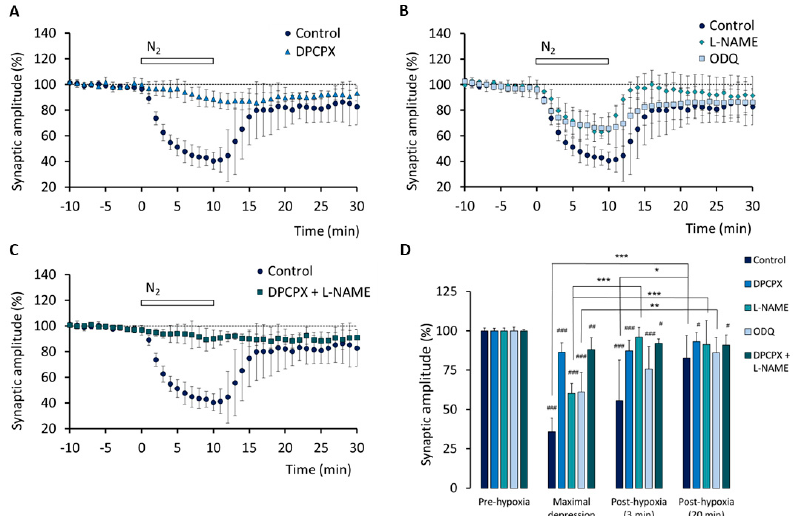
Figure 3. Involvement of adenosine A 1 receptors and NO/cGMP in hypoxia-induced depression of the synaptic component of the fEPSPs. Time course of hypoxia effect on the amplitude of the synaptic peak in control conditions ( n = 5) and after pre-treatment with: ( A ) the A 1 receptors antagonist DPCPX (50 nM; n = 4); ( B ) the NO synthase inhibitor L-NAME (2 mM; n = 5) or the NO-sensitive GC inhibitor ODQ (100 µM; n = 5); ( C ) both DPCPX (50 nM) and L-NAME (2 mM) ( n = 4). ( D ) Comparison of the mean amplitude (± SD) of the synaptic peak recorded during the 10 min before hypoxia onset (pre-hypoxia), during the minute corresponding to the maximal hypoxia-induced depressive effect, and during min 3 and min 20 after re-oxygenation onset in the different conditions indicated. ### p < 0.001, ## p < 0.01; # p < 0.05 (vs. pre-hypoxia). *** p < 0.001, ** p < 0.01, * p < 0.05 (vs. the columns indicated).